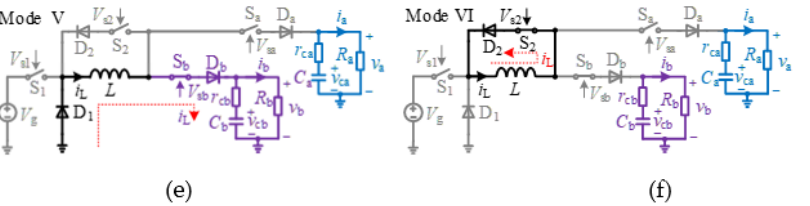
Figure 2. Equivalent circuits for PCCM SIDO buck converter: ( a ) Mode I: Charging interval of output A; ( b ) Mode II: Discharging interval of output A; ( c ) Mode III: Freewheeling interval of output A; ( d ) Mode IV: Charging interval of output B; ( e ) Mode V: Discharging interval of output B; ( f ) Mode VI: Freewheeling interval of output